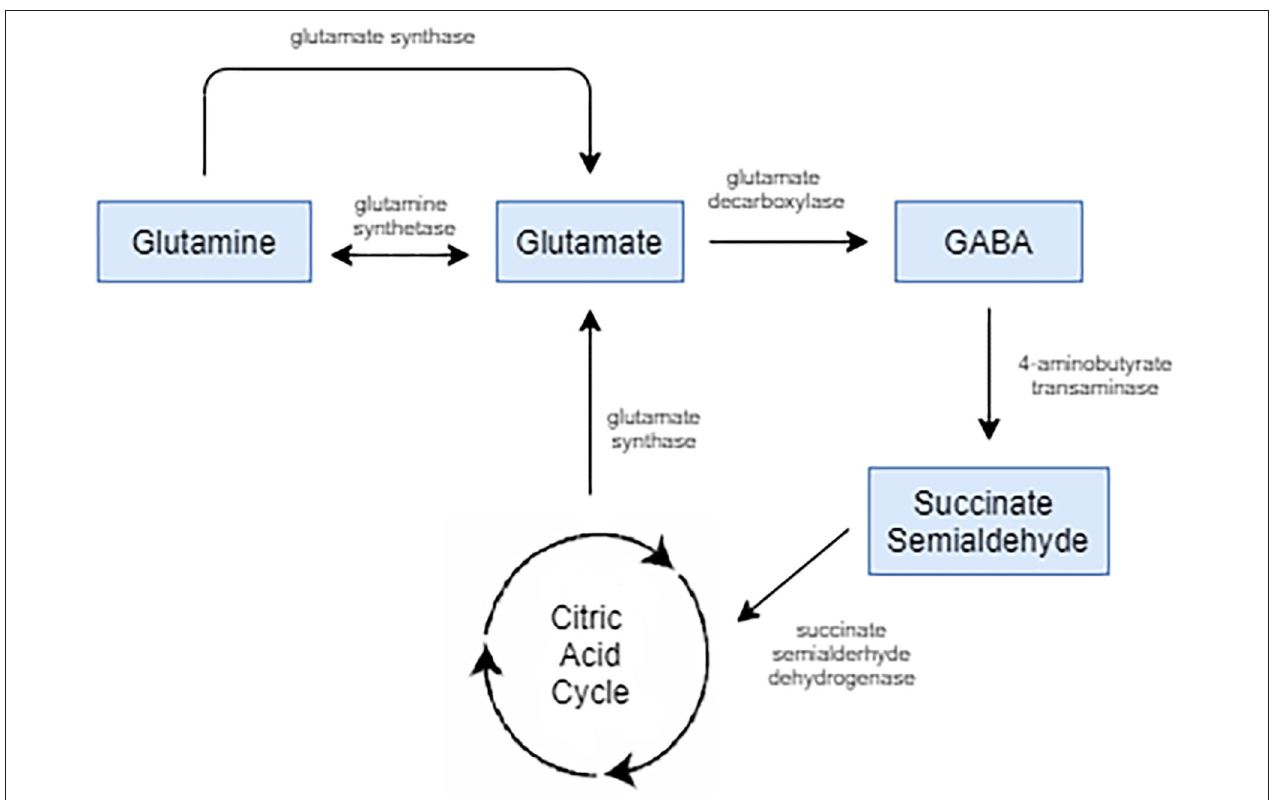
FIGURE 1 | Glutamate is the biological precursor for GABA. Glutamate is synthesized from the nonessential amino acid glutamine, and glutamate is converted into GABA by the enzyme glutamate